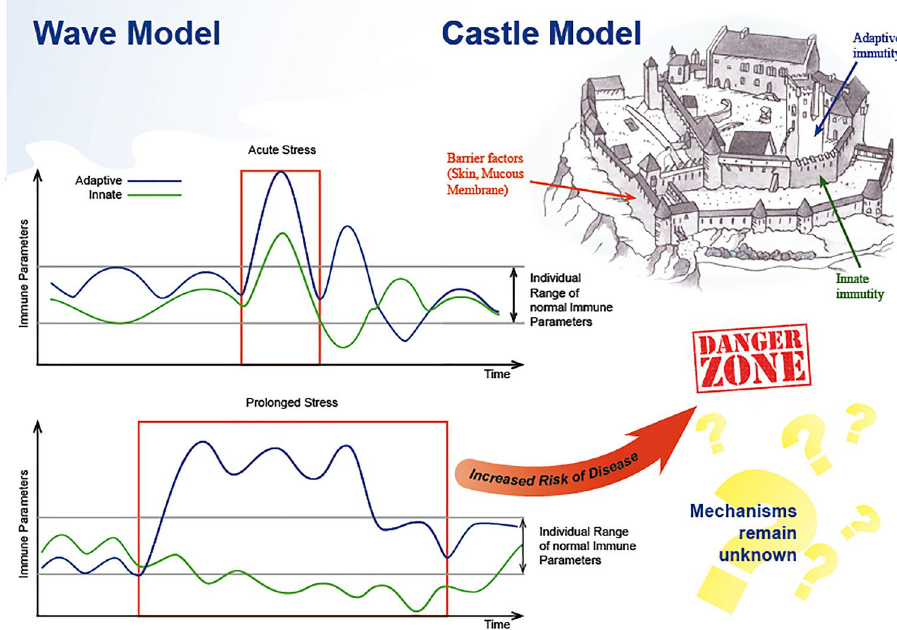
Figure 7. The two models of immune system functioning.